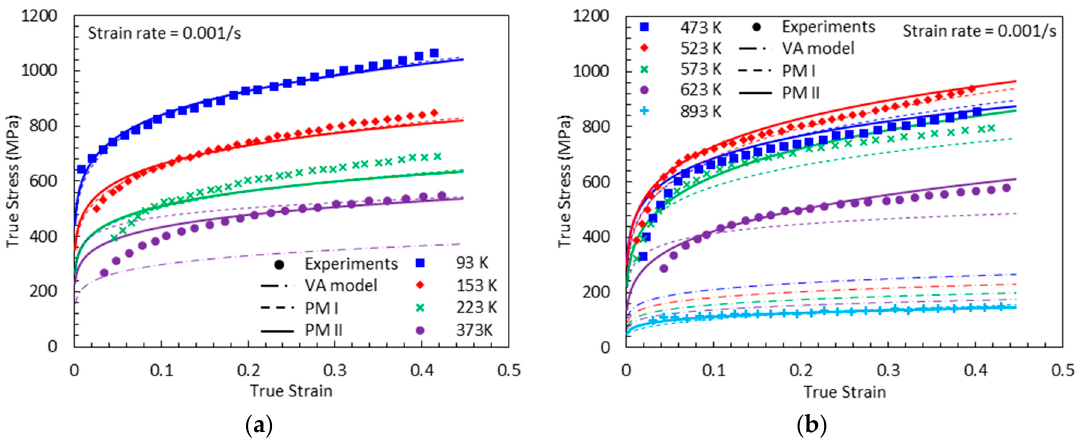
Figure 19. True stress-true strain curves from experimental measurement [1] , predictions by the VA model, proposed model (PM) I, and PM II with 0.001 s − 1 : ( a ) T = 93, 153, 223 and 373 K ( b ) T = 473, 523, 573, 623 and 893 K .